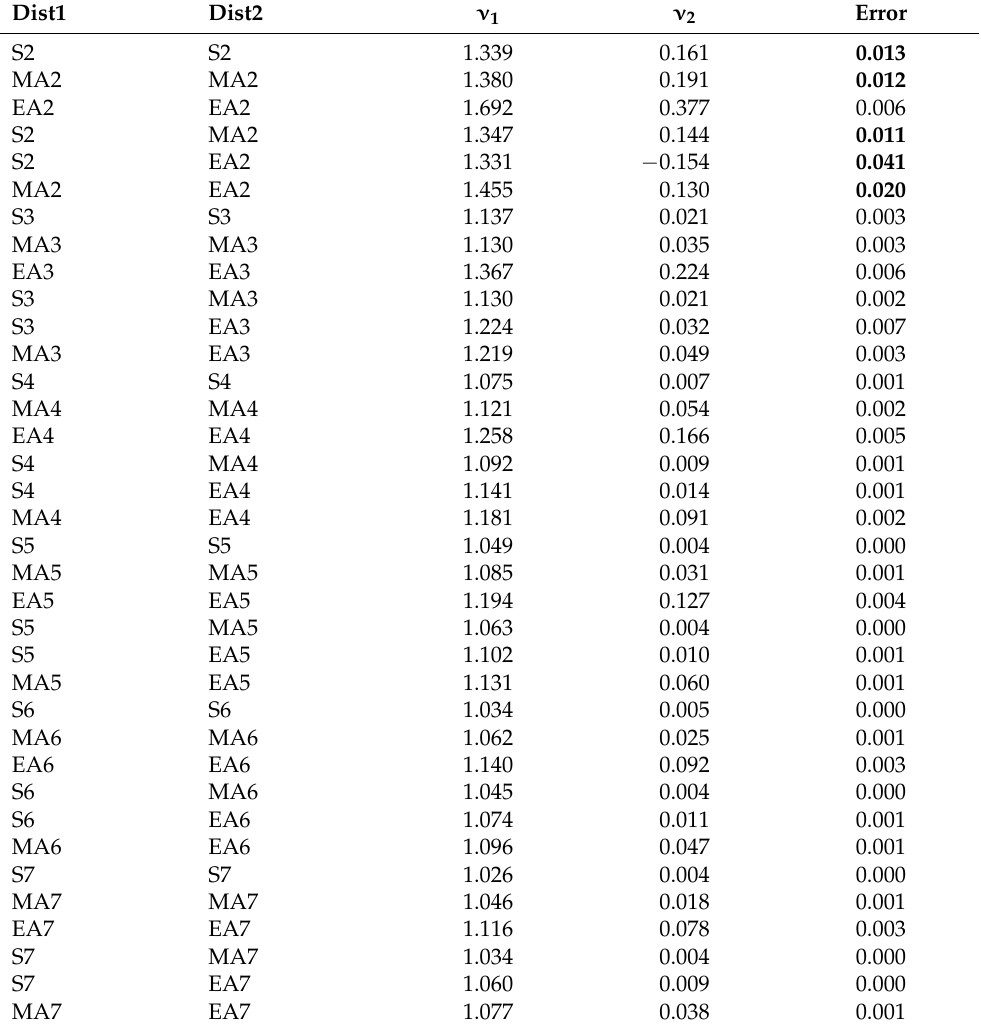
√ √ √ ρ ∗ (cid:39) ν ρ ( 1 − ν 2 ρ ) of the square root of the polychoric correlation 1 √ ρ